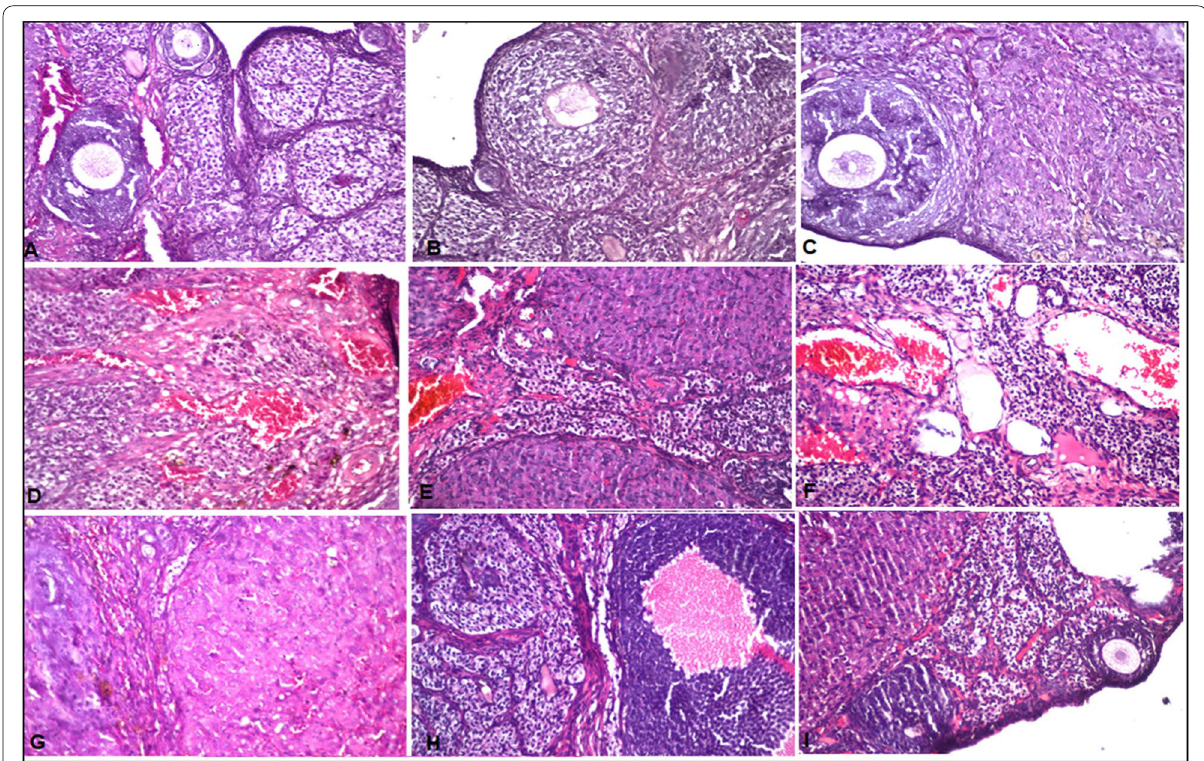
Fig. 3 a Control group: Interstitial stromal cells with primary and secondary follicles and few corpus luteum were detected ( a and b ). c Control rats received P. columbinus extract; there is no alteration in the primary and secondary follicles. d Group of rats injected CTX: Sever congestion was detected in the medullary blood vessels associated with mature follicle and corpus luteum in the cortex. There was congestion in the medullary portion associated with few atretic follicles as well as multiple corpus luteum ( e ). There was multiple corpus luteum with few follicles as well as interstitial stromal cells in the cortex. Sever congestion was detected in the medullary blood vessels. There was multiple corpus luteum with few follicles as well as interstitial stromal cells in the cortex ( e and f ). Sever congestion was detected in the medullary blood vessels ( g ). ( h and i ) CTX P. columbinus extract (100 mg/kg): Interstitial stromal cells with normal primary and secondary follicles. j Oral treatment of P. columbinus extract (100 mg/kg) on the number of follicles in rats treated with CTX